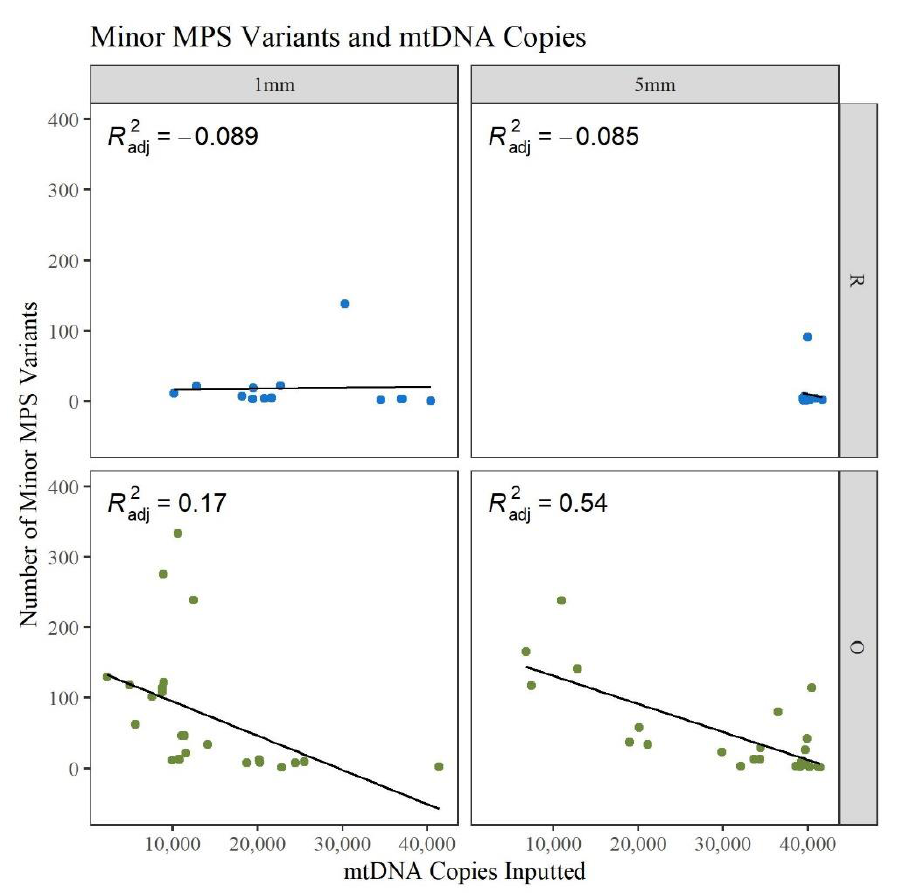
Figure 6. Linear regression of the number of reported minor MPS variants compared to the number of mtDNA copies inputted to the amplification reaction (n = 74; n R = 26, n O = 48).